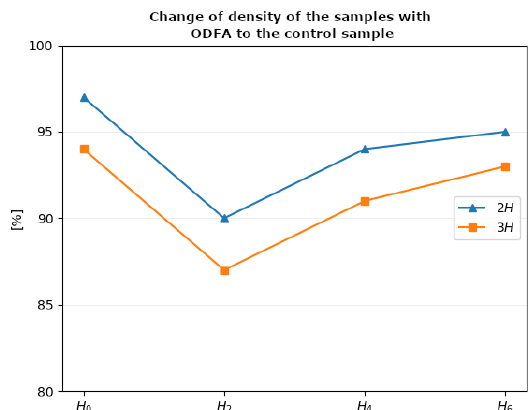
Figure 10. Increase in density of the composite samples with ODFA and lime in comparison to the control sample.